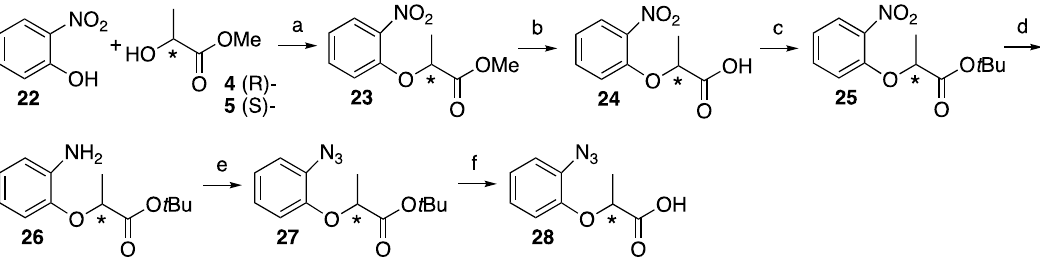
Figure 3. Synthesis of 4- and 3- azide-substituted lactisole derivatives. ( a ) (1) PPh 3 , CH 2 Cl 2 , 0 °C, 10 min; (2) DEAD, CH 2 Cl 2 , rt, 8 h, ( S )- 14 99%, ( R )- 14 quant., ( S )- 15 quant., ( R )- 15 quant, ( b ) H 2 , Pd/C, CH 3 OH, rt, 2 h, ( S )- 16 quant., ( R )- 16 quant., ( S )- 17 quant., ( R )- 17 87%, ( c ) (1) NaNO 2 , HCl, H 2 O, 0 °C; (2) NaN 3 , 0 °C, 30 min, then rt, 30 min, ( S )- 18 quant., ( R )- 18 93%., ( S )- 19 92%., ( R )- 19 85%, ( d ) NaOH, CH 3 OH, H 2 O, reflux, 5 h, ( S )- 20 91%, ( R )- 20 96%, ( S )- 21 quant., ( R )- 21 81%.